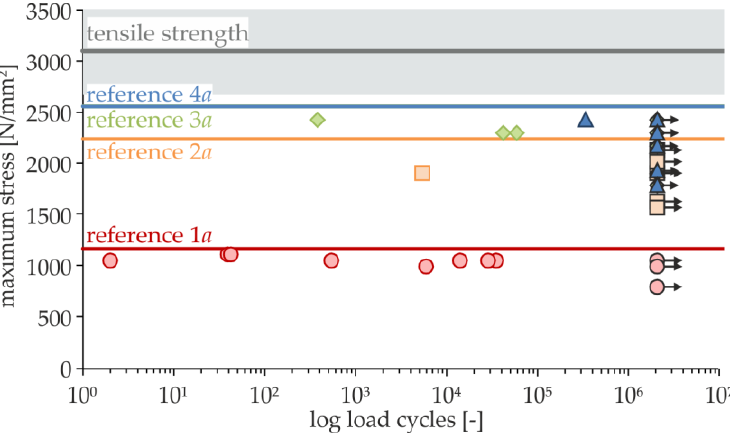
Figure 14. S-N diagram with absolute maximum stresses for DPO tests with different anchorage lengths.